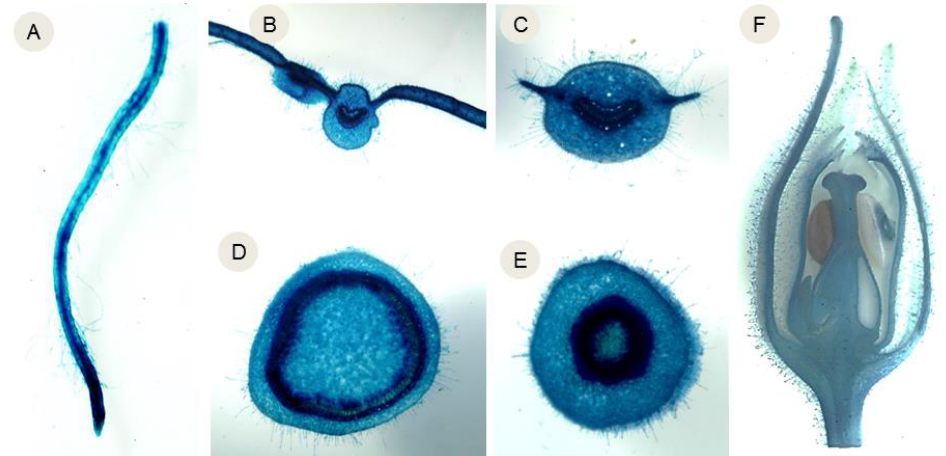
Figure 1. Histochemical analysis showing GUS activity (indicated by blue staining) in various structures of transgenic plants carrying the ‘pollen- and seed-specific Gene Deletor’ cassette. ( A ) Root, ( B ) leaf section, ( C ) petiole section, ( D ) stem section, ( E ) flower stalk section, ( F ) flower section. Scale bar = 20 µM. Table 2. Transgene excision efficiency in the pollen and seeds of transgenic plants grown in a green- house; transgene excision efficiency was determined based on GUS staining of the T1 seedlings. Lines C1, C14, and C6 (control lines); lines D4, D10, D31, D56, and D43 (lines with “Gene Deletor”